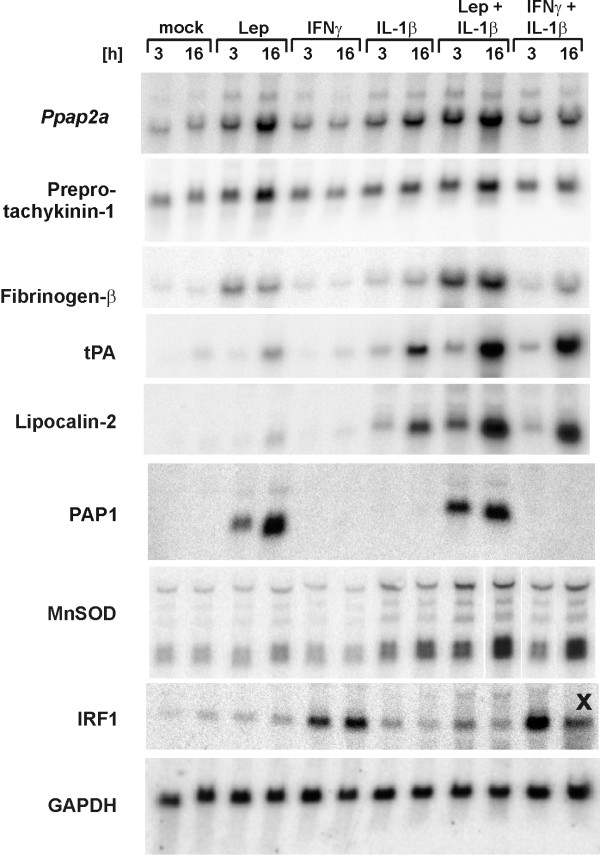
Effects of leptin and IFNγ on inflammation-related transcripts. RINm5F cells were treated with the indicated cytokines (100 ng/ml leptin; 50 u/ml IL-1β; 25 ng/ml IFNγ) or combinations thereof for 3 h or 16 h before total RNA was isolated. mRNA levels of the indicated genes were assessed by Northern blot hybridisation. GAPDH was used as a control. The RNAs from leptin and/or IL-1 β treated cells were obtained in an experiment independent from that shown in Figure 1. A sample of partially degraded RNA on one of the blots is marked with an x.